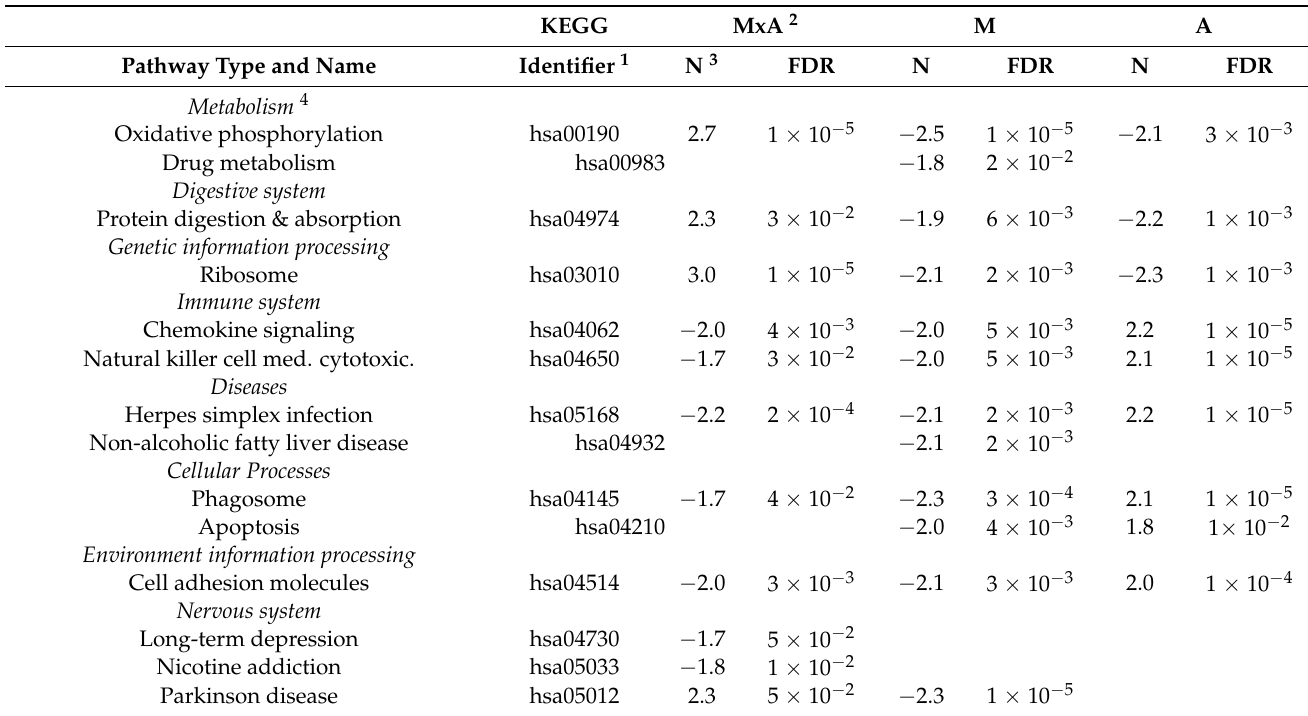
Table 1. Enriched pathways (Gene Set Enrichment Analysis False Discovery Rate-adjusted p -value < 0.05 and normalized enrichment score absolute value |NES| > 1.5) among genes pre- senting morphine (M), maternal immune activation (A), or interactions (MxA) effects in the prefrontal